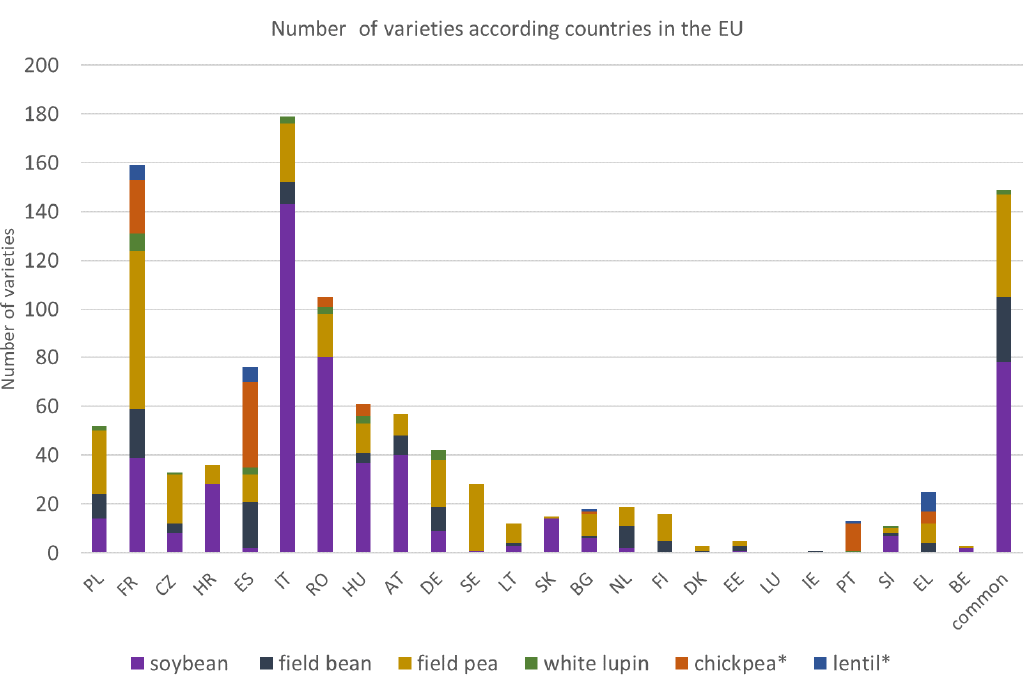
Figure 4. Number of varieties registered on the national variety lists of EU countries in 2021 [44].